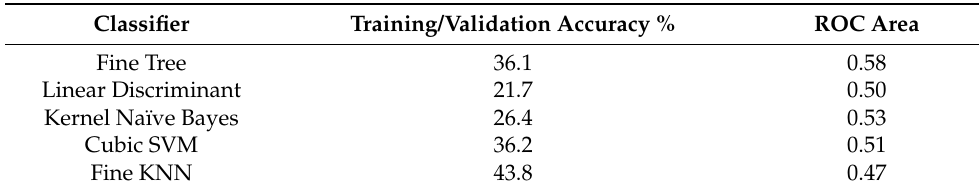
Table 3. Classification performance of different algorithms on data from simulation using handcrafted statistical features.